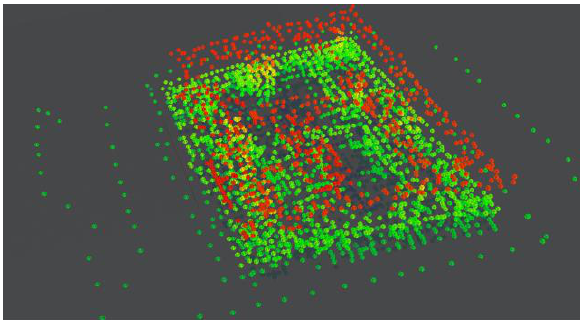
Figure 9. Topological relations of a corridor